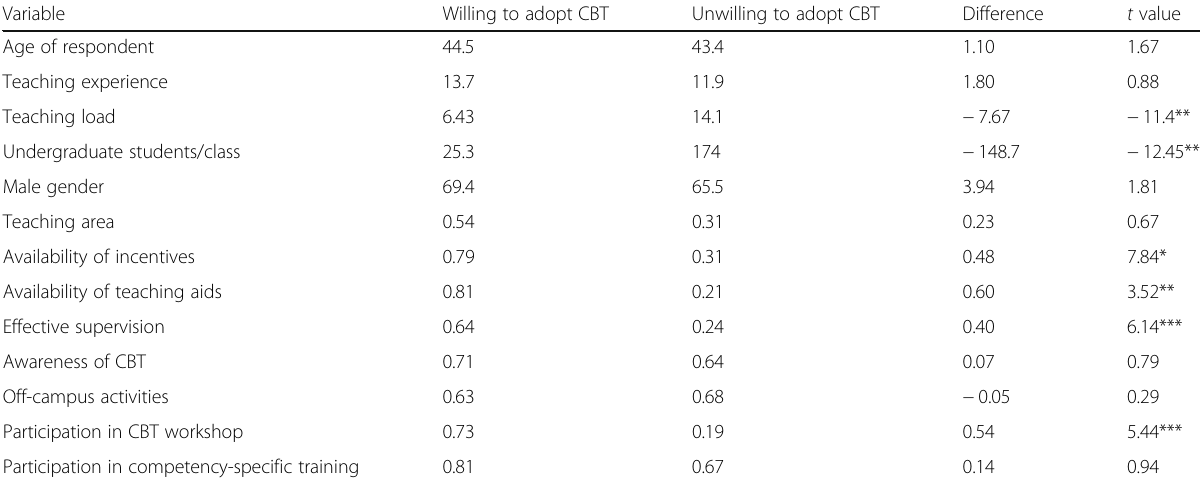
Table 3 Test of equality of means of characteristics of adopters and non-adopters of CBT